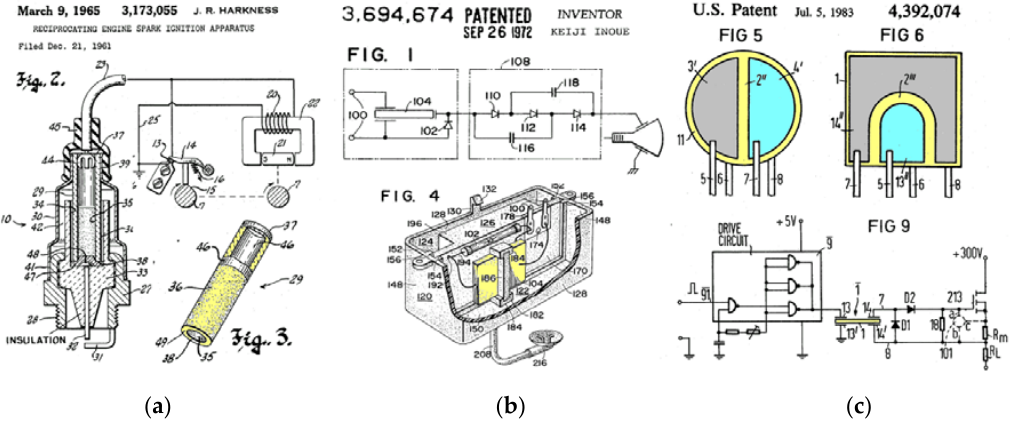
Figure 7. Some representative applications considered for piezoelectric transformers during the 1970s and 1980s. ( a ) Gate drivers for solid state switches; ( b ) High voltage power supply for TV cathode-ray tube; ( c ) Application in small engine ignition.